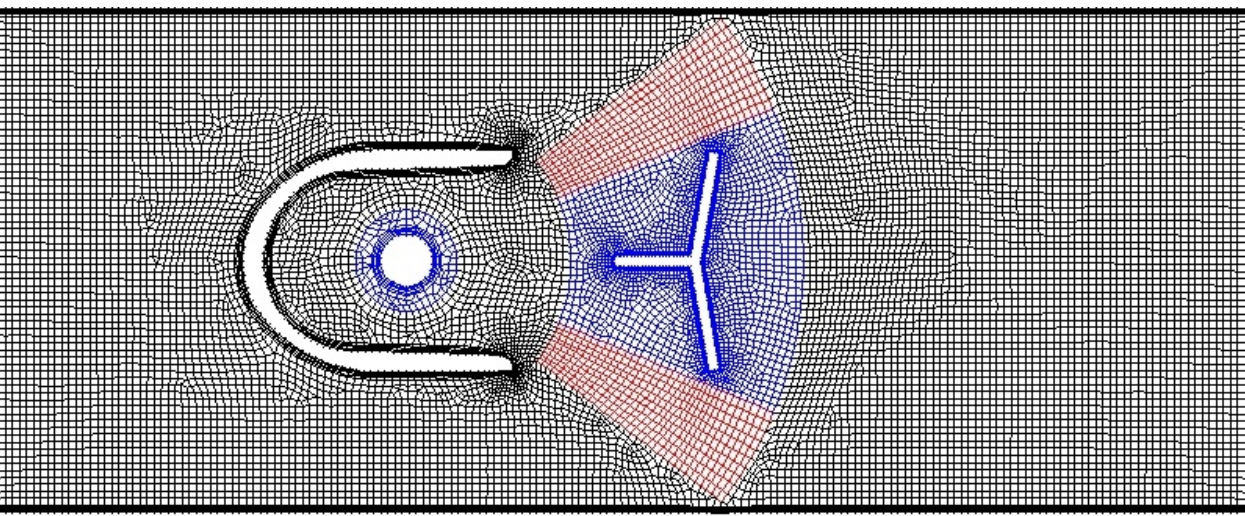
Figure 11. Two-dimensional mesh for the layering method: black—stationary zone; red—layering zone; blue—rigid zone.